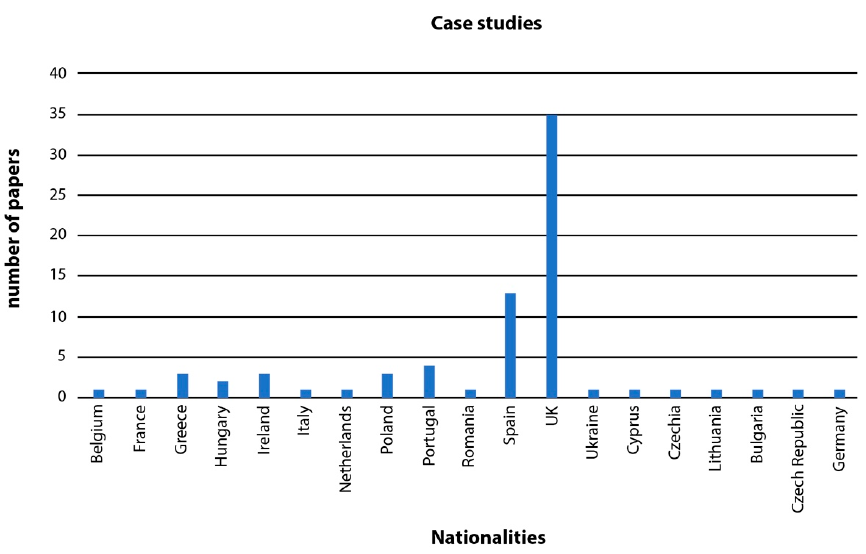
Figure 3. The graphic in the image represents the geographic distribution of the papers analyzed.